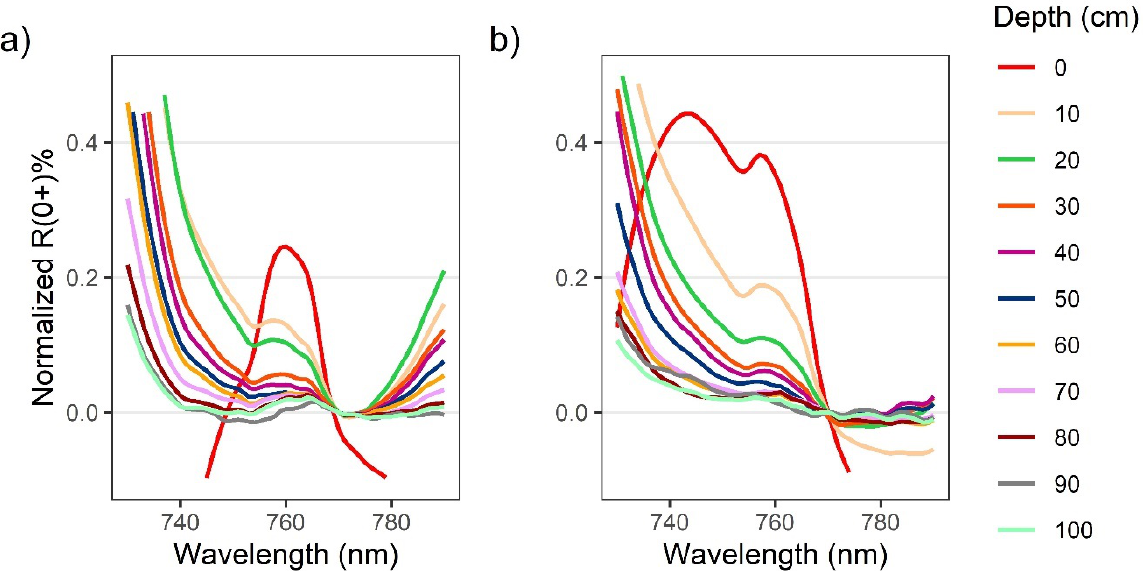
Figure 4. Zoomed in plot showing solar-induced chlorophyll fluorescence (SICF) peaks centered at 761 nm for above-water R 0+ for Nereocystis bulbs ( a ) and blades ( b ) at incremental depths below the water surface. Spectra are normalized at 770 nm to show relative changes to the shape of the SICF peak with submergence.